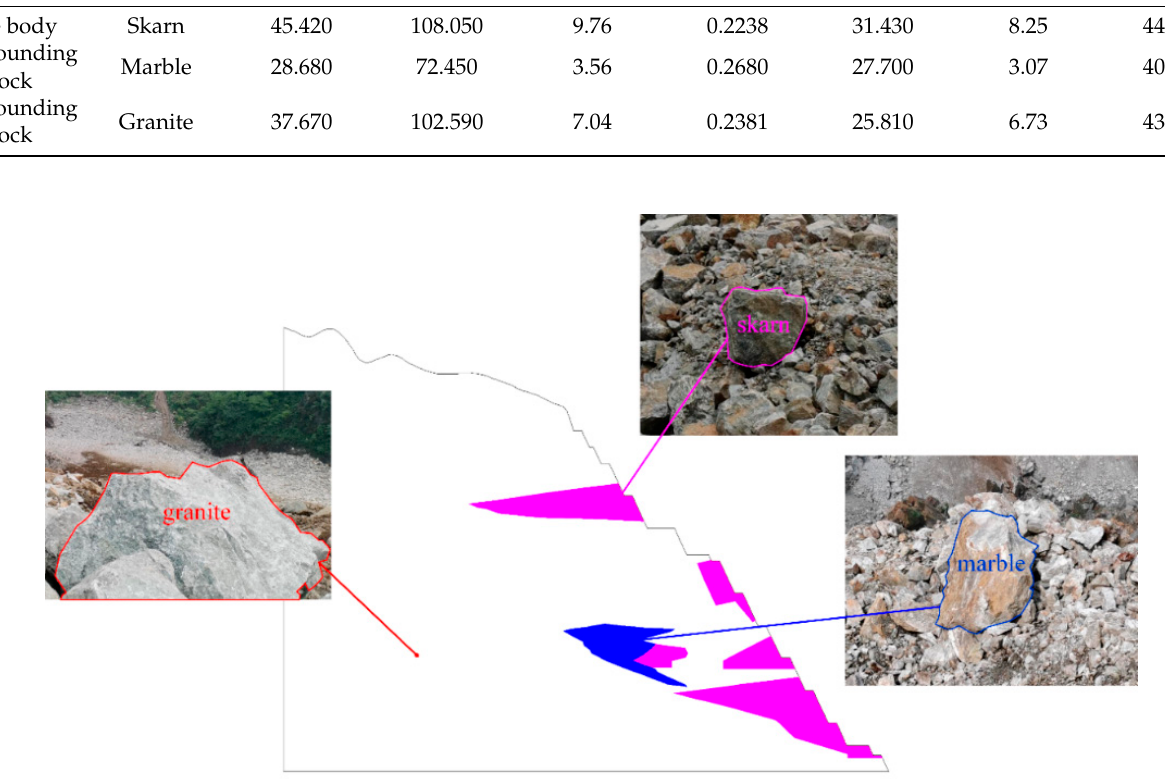
Figure 3. The geological section of the R1 slope of the open pit. Table 1. Rock mechanics parameters of slope rock after engineering reduction.